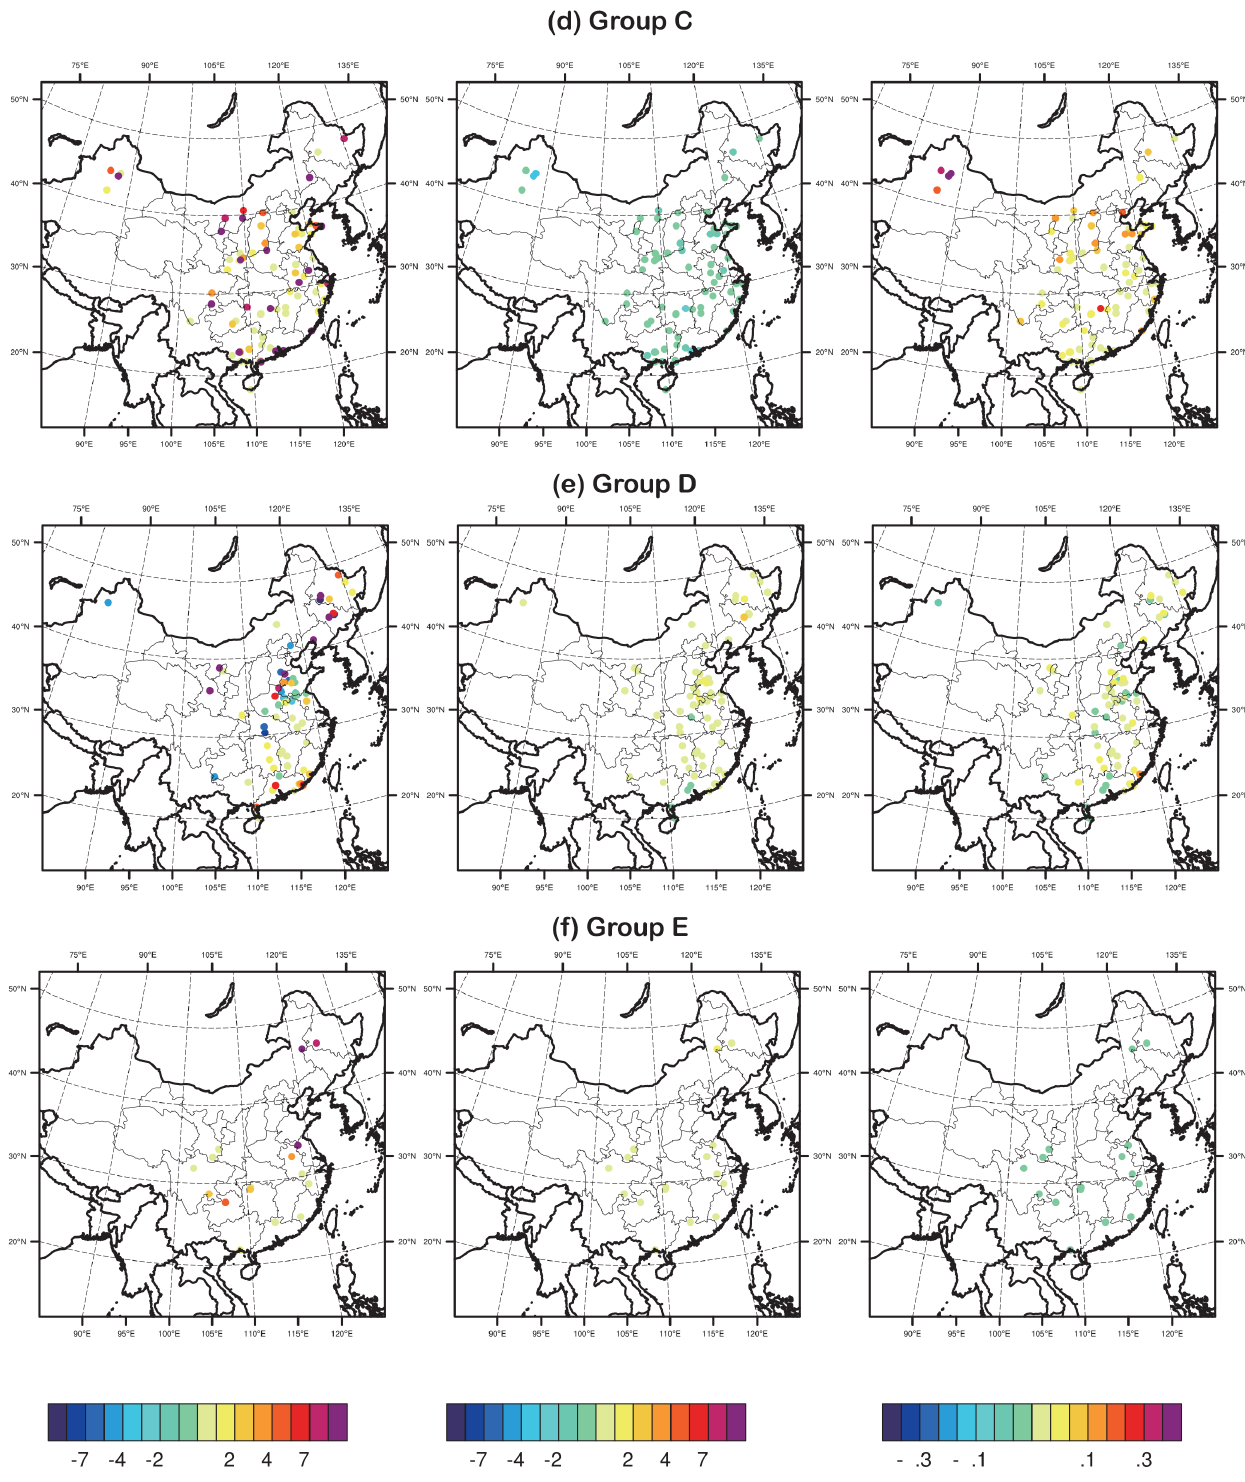
Figure 11. The spatial distribution of the error statistics between the model simulations and the observations for January 2015. (a) Statistics between NO_DA_FCST and the observations, with BIAS and RMSE in micrograms per cubic meter; (b–f) the statistics improvements from NO_DA_FCST to EMIS_DA_FCST for different groups of sites (classification in Table 4), with the BIAS and RMSE improvements shown as percentages. The color bars are the same for (b) – (f) and are only shown in (c) and (f) to save